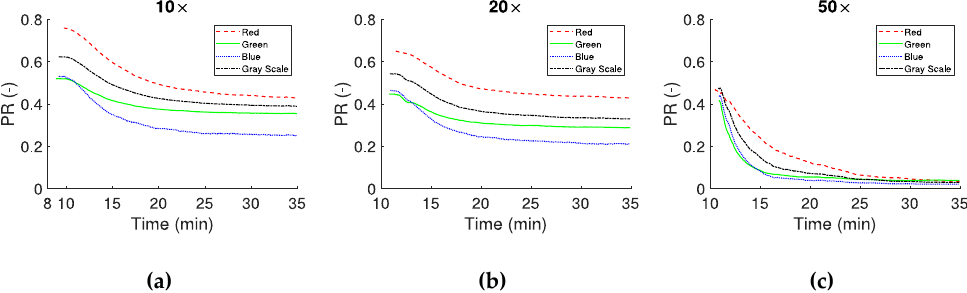
Figure 6. Plasma reduction ( PR ) as the ratio between the RBCs/clots and the plasma, of sequential images in time after CS. Panels ( a – c ) show the results from the 10×, 20× and 50× magnifications respectively.